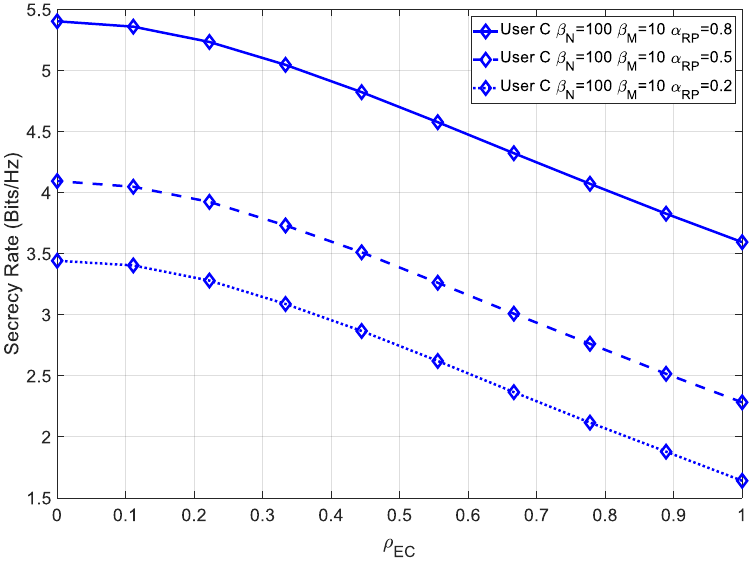
Figure 15. Secrecy rate of the 8 × 8 receiver C with channel estimation errors on both the receiver and eavesdropper, as well as a permanent channel mismatch error, for various ray power